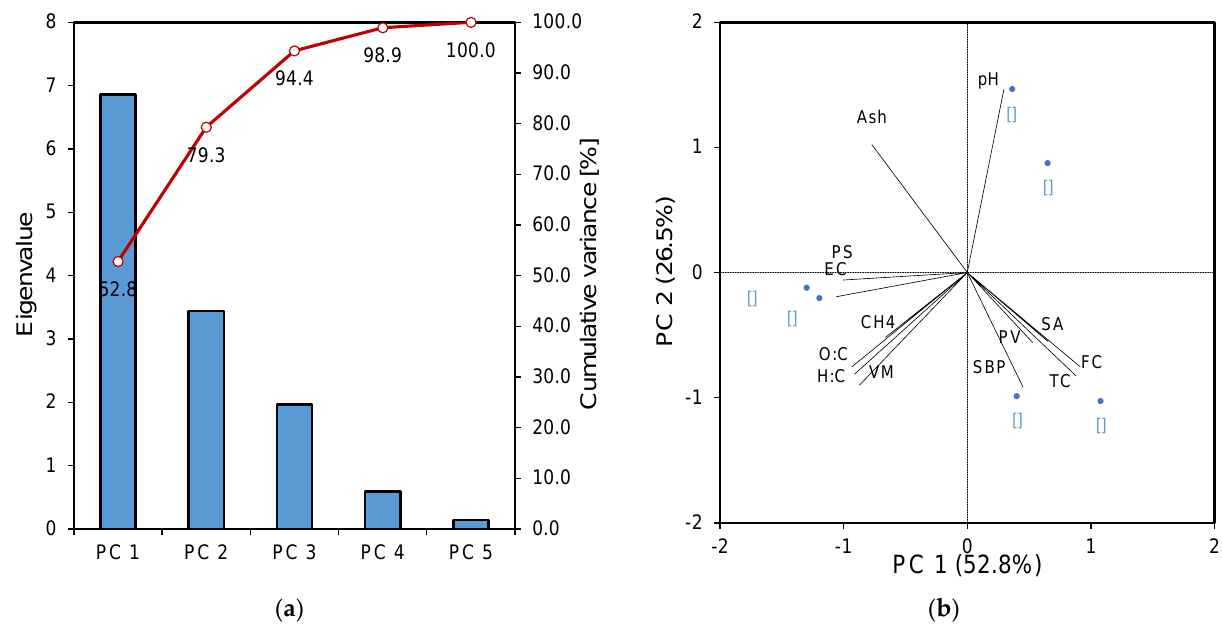
Figure 3. Results of principal component analysis (PCA) between physic-chemical properties of the biochars, biogas and methane productions: ( a ) Scree plot of the first principal components (PCs); ( b ) Biplot with loadings and scores for PC1 and PC2.